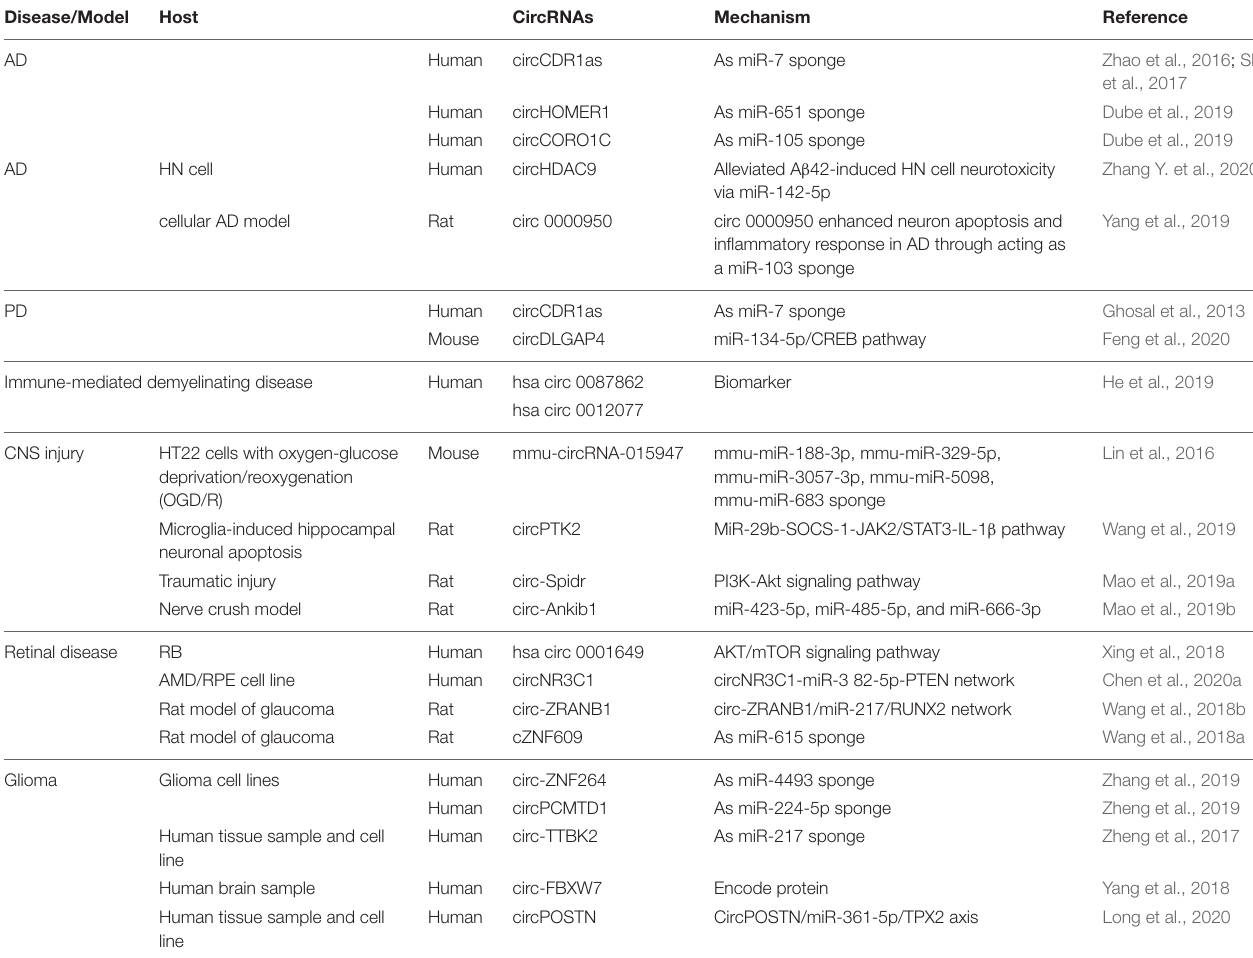
TABLE 1 | CircRNAs in neurological